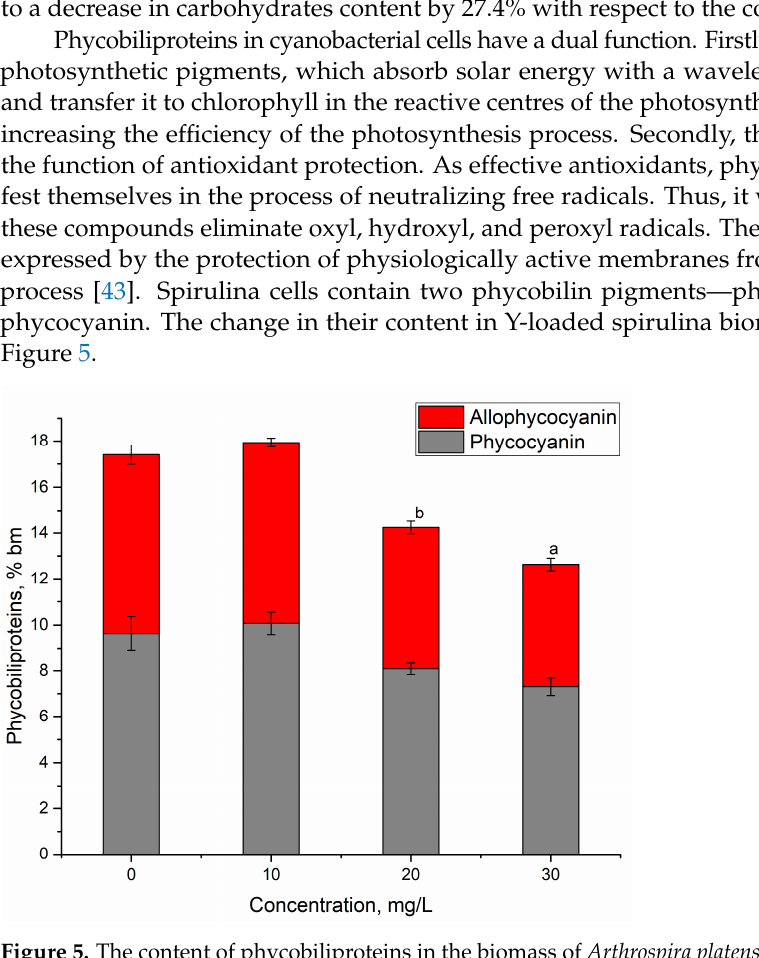
Figure 6. The content of pigments in the biomass of Arthrospira platensis exposed to Y(III) at a con- centration of 10–30 mg/L (a— p < 0.01 for the difference between sample and control—chlorophyll).